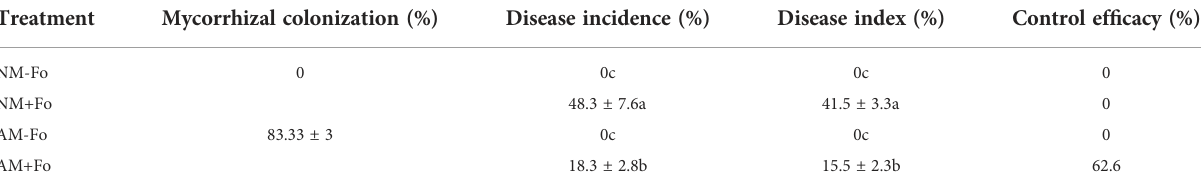
Valuesaremeans±SDfromfoursetsofindependent experimentswith60potspertreatmentforeachsetofexperiments.Differentlowercaselettersindicatesigni fi cantdifferencesbetween different treatments according to two-way ANOVA followed by Tukey ’ s test for multiple comparisons (P < 0.05).